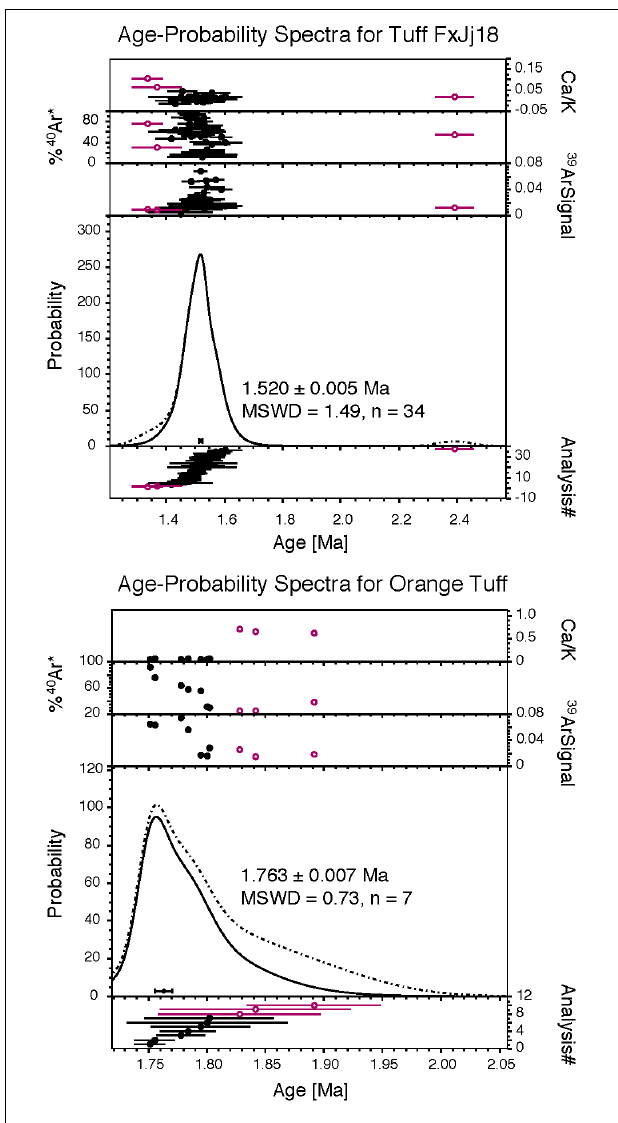
FIGURE 5 | Results of total fusion single crystal 40 Ar/ 39 Ar analyses for feldspars from the FxJj18 tuff and the Orange Tuff. All reported errors are 1-sigma. See Supplementary Table S1 for detailed total fusion data and analytical conditions. High Ca/K ratios are used to screen grains that are not sanidines. Empty symbols represent data omitted from the calculated